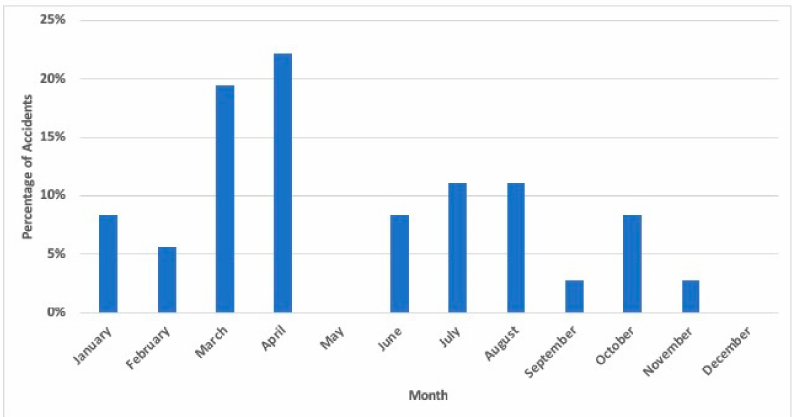
Figure 3. The distribution of accidents’ number based on